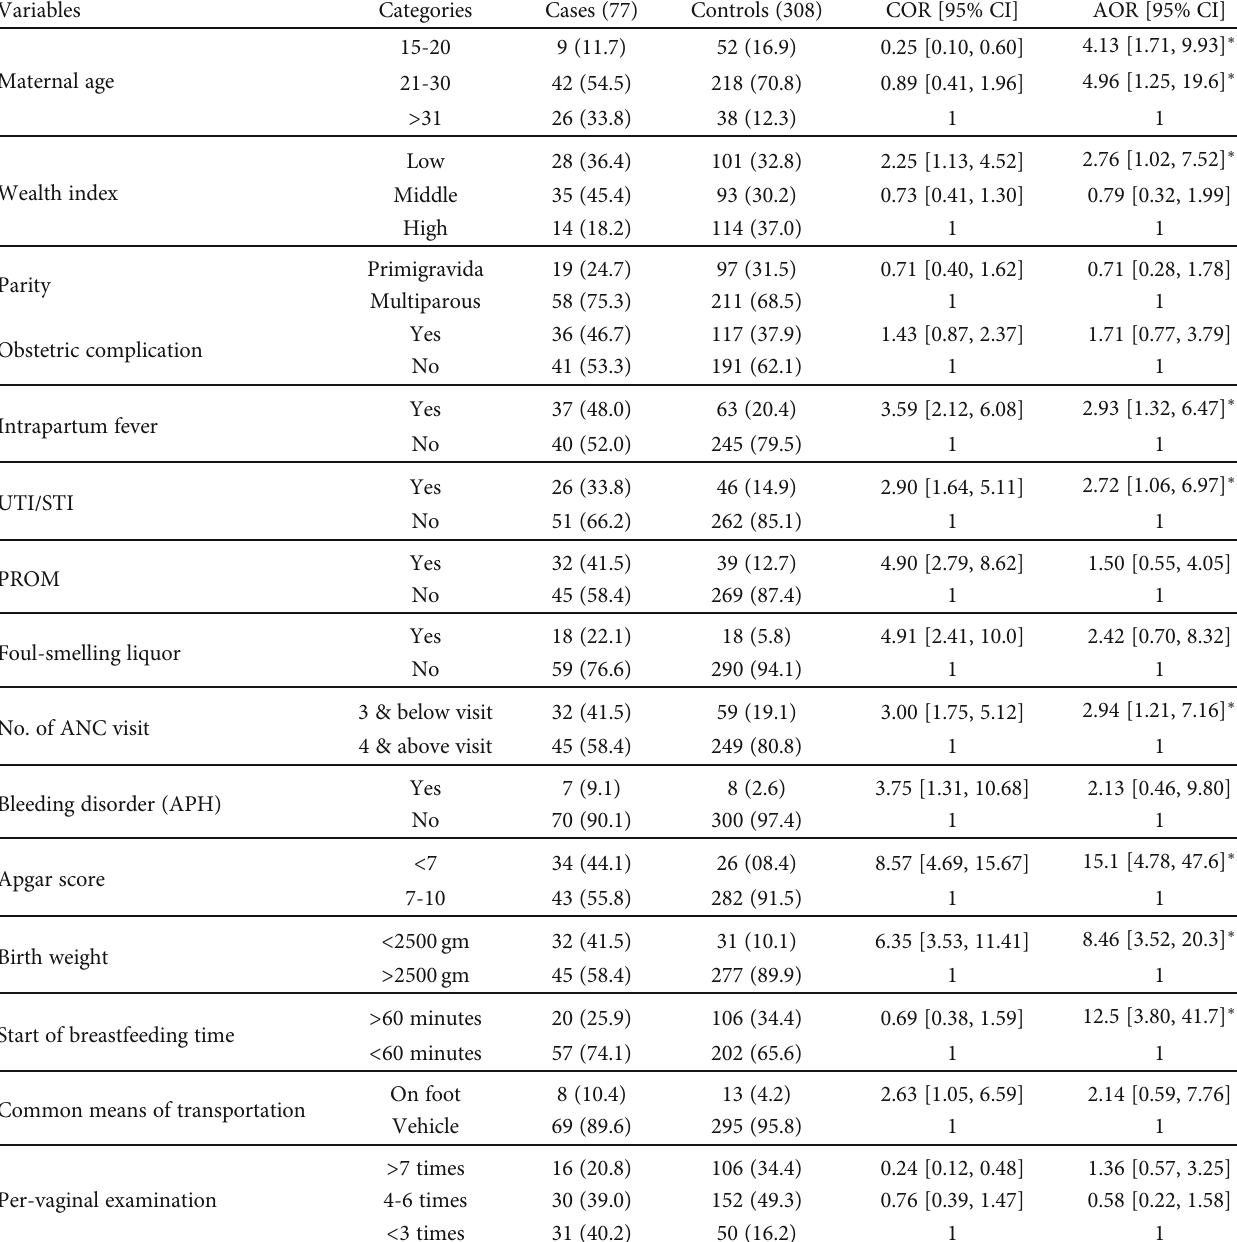
Table 6: Bivariate and multivariate analyses of neonatal sepsis neonates at SCGH and WSUTRH, Wolaita Sodo town,